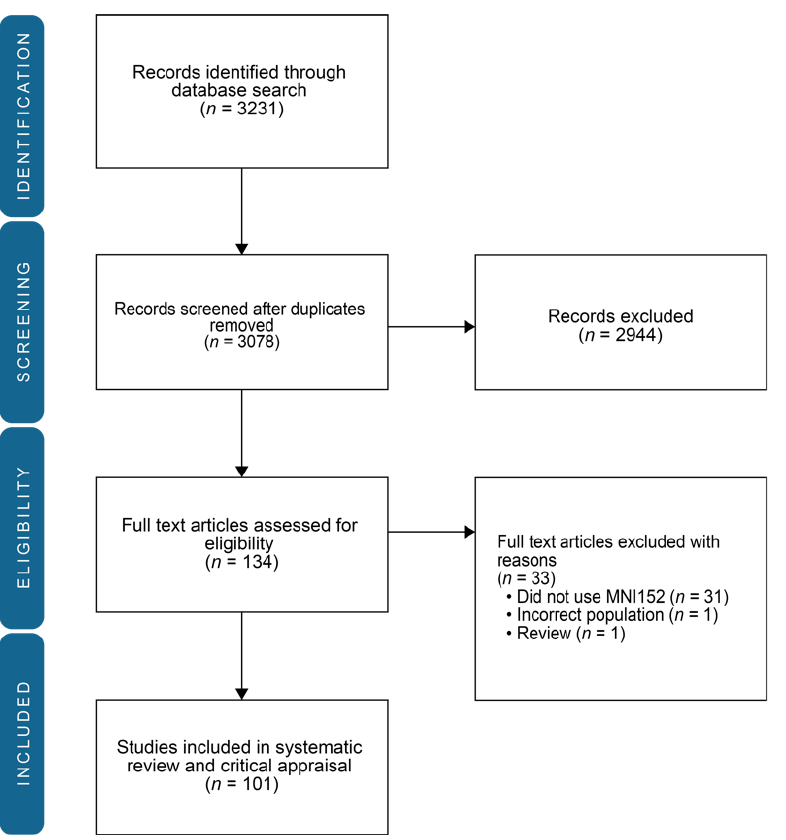
Figure 2. PRISMA study flow diagram . Summary of the number of articles screened and included.